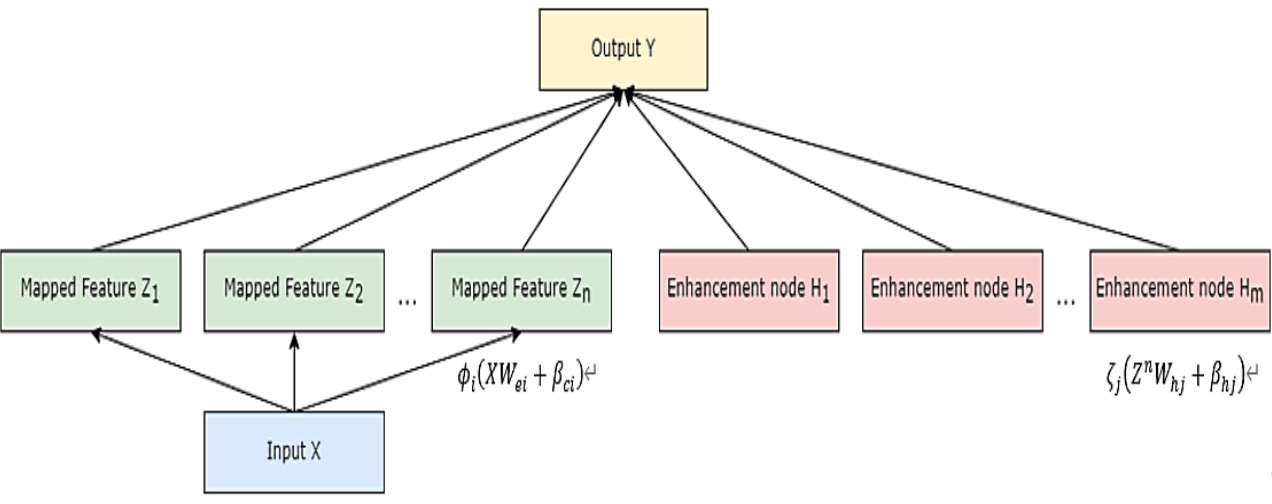
Figure 1. The structure diagram of BLS.